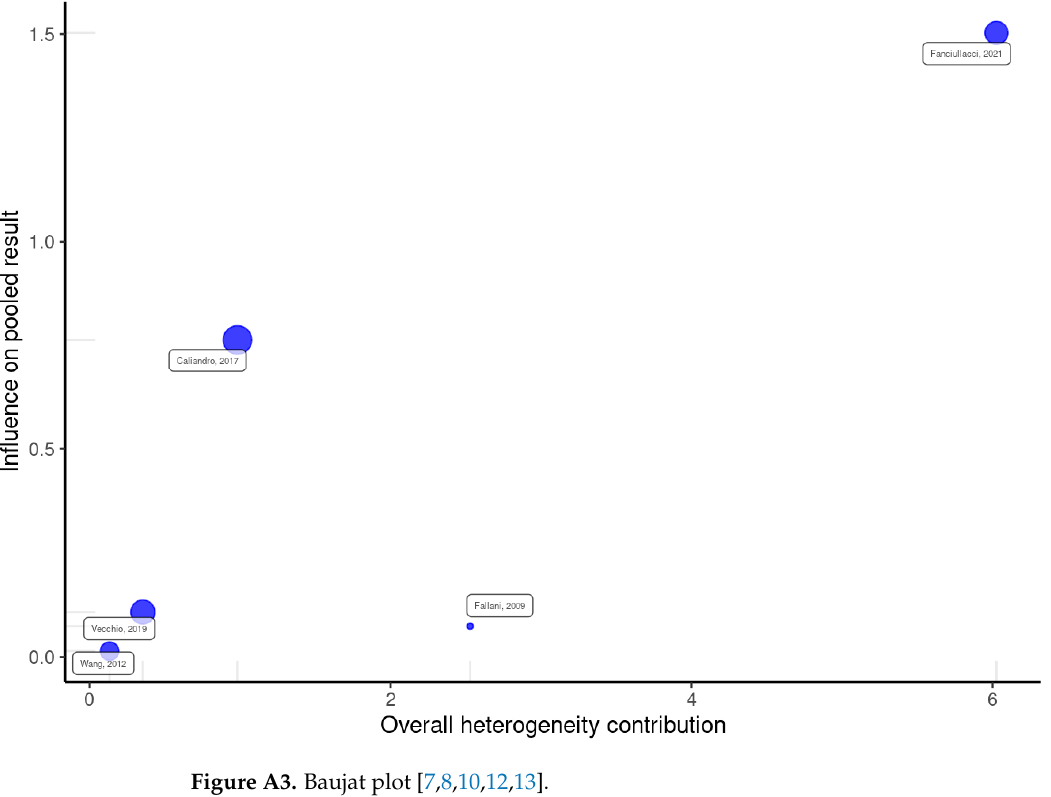
Figure A3. Baujat plot [7,8,10,12,13].